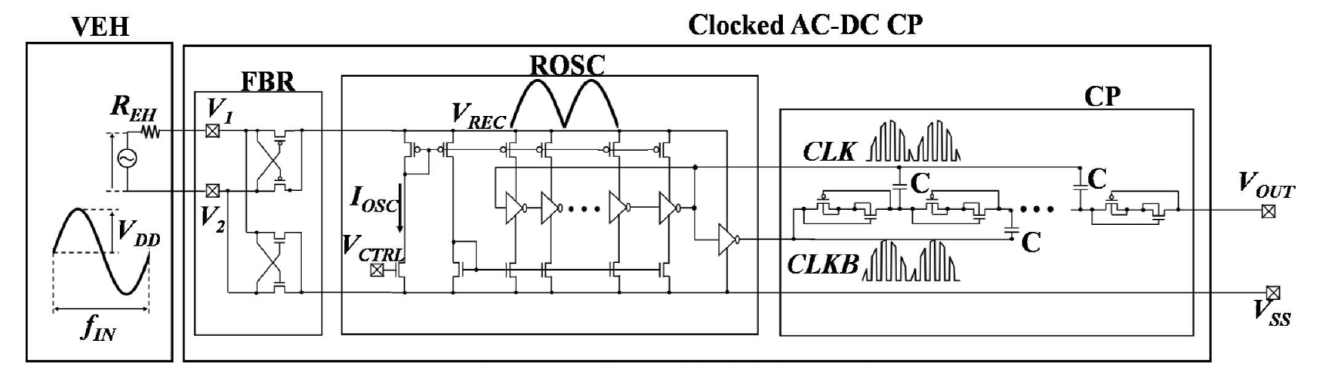
Figure 21. The fully integrated AC-DC converter presented in